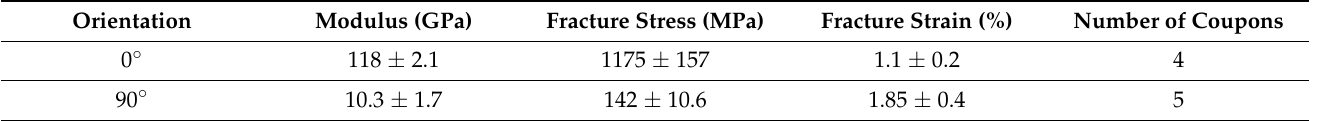
Figure 6. Compression fracture modes at different orientations; ( a , b ) top and side views, 90°; ( c , d ) top and side view, 0°; ( e ) the kinking phenomena.